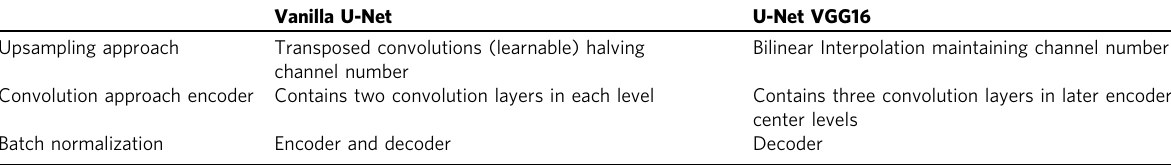
Table 3 Architectural differences between the vanilla U-Net and the U-Net